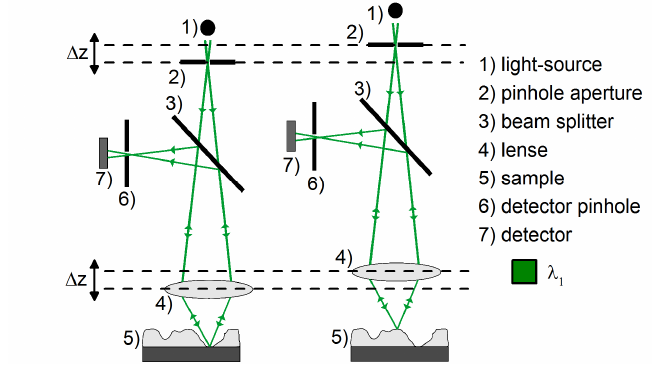
Figure 1. Schematic principle of confocal microscopy for topography-mapping for VACNT forest height characterization. While, on the left side, only the light from substrate surface is reflected directly, on the right side the light is reflected directly from the top of